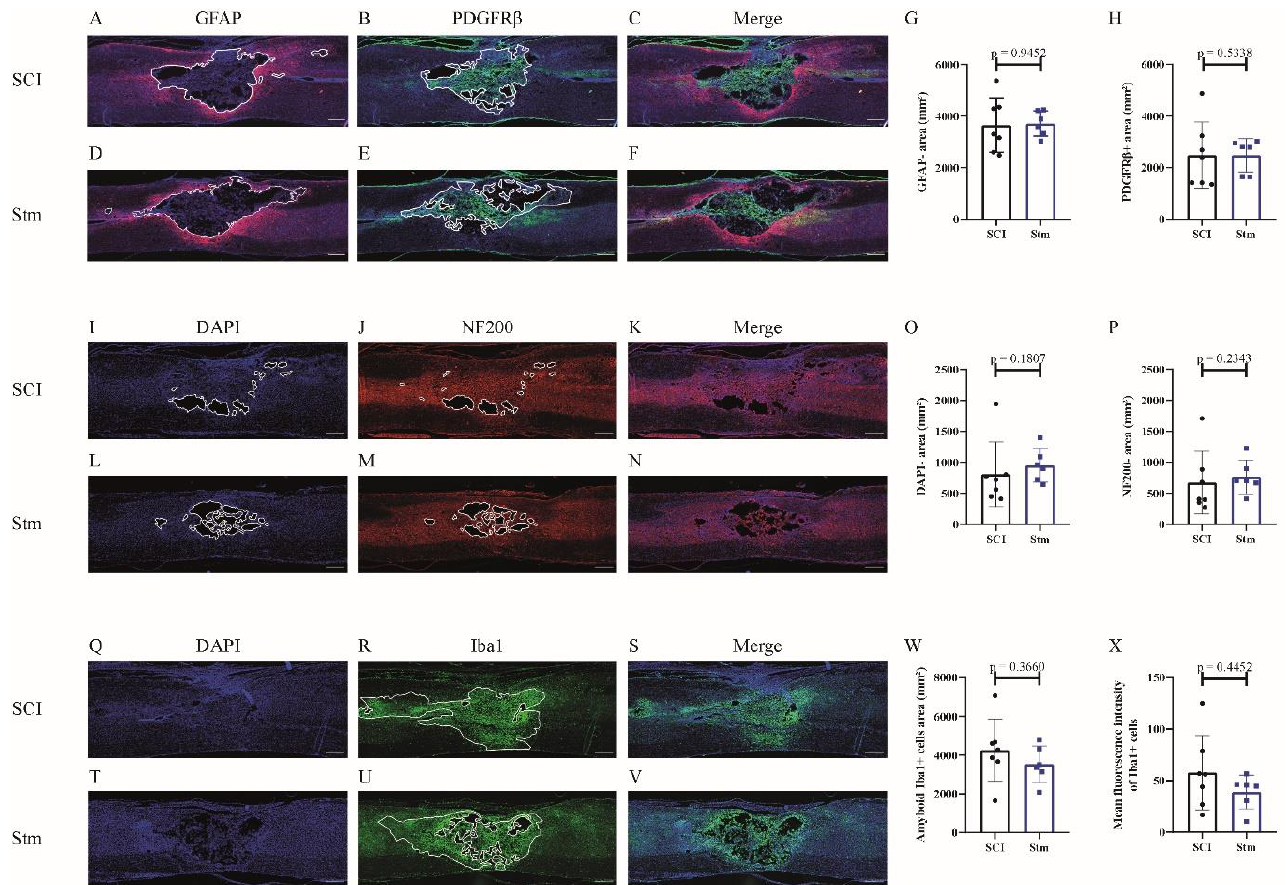
Figure 8. rTSMS treatment does not have effect on tissue repair after contusive SCI in rats 15 days after SCI. At day 15, immunohistological analyses were performed. ( A – V ) Representative pictures of sagittal spinal cord sections of ( A – C , I – K , Q – S ) SCI and ( D – F , L – N , T – V ) Stm (rTSMS treated) animals. Sections were stained with ( A , D ) GFAP, ( B , E ) PDGFRβ, ( I , L , Q , T ) DAPI, ( J , M ) NF200 and (R and U) Iba1. ( G ) Quantification of astrocytic-negative area (GFAP-). ( H ) Quantification of fibrosis-positive area (PDGFRβ+). ( O ) Quantification of DAPI-negative area (DAPI-). ( P ) Quantification of NF200-negative area (NF200-). ( W ) Quantification of Iba1-amyboid-positive cells’ area (Iba1+) and ( X ) quantification of Iba1+ mean fluorescence intensity. Scale bars are 200 µm; n = 7 animals per SCI group and n = 6 animals per Stm group. Quantifications are expressed as average ± SD. Statistical evaluations are based on the Mann–Whitney test.